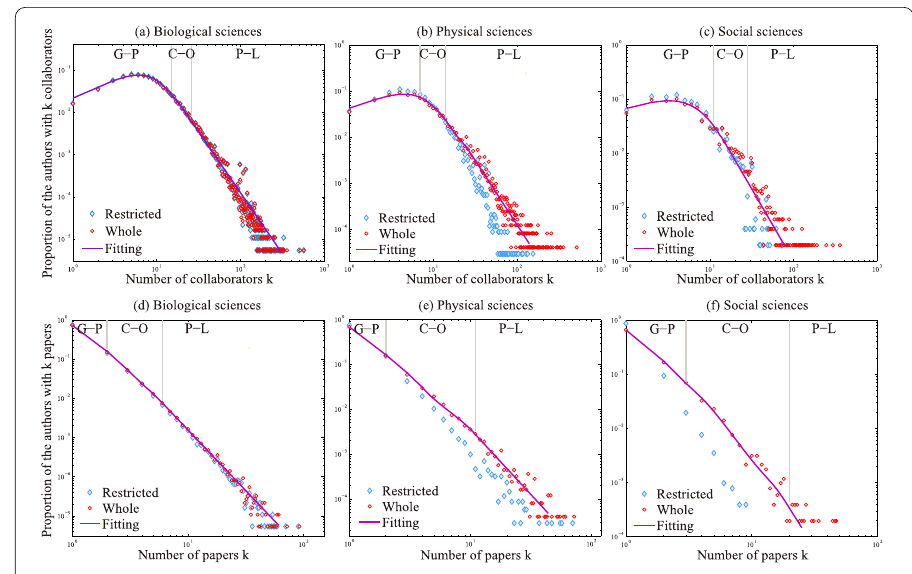
Figure 3 Distributions of collaborators/papers per author. The panels show the distributions counted in PNAS 1999–2013 (red plots), and those counted in the papers of each science category (blue diamonds). Fitting distributions (purple curves) are mixtures of a generalized Poisson distribution and a power-law distribution. Fitting parameters are listed in Table 4. The regions “G-P”, “C-O”, “P-L” stand for generalized Poisson, cross-over and power-law respectively